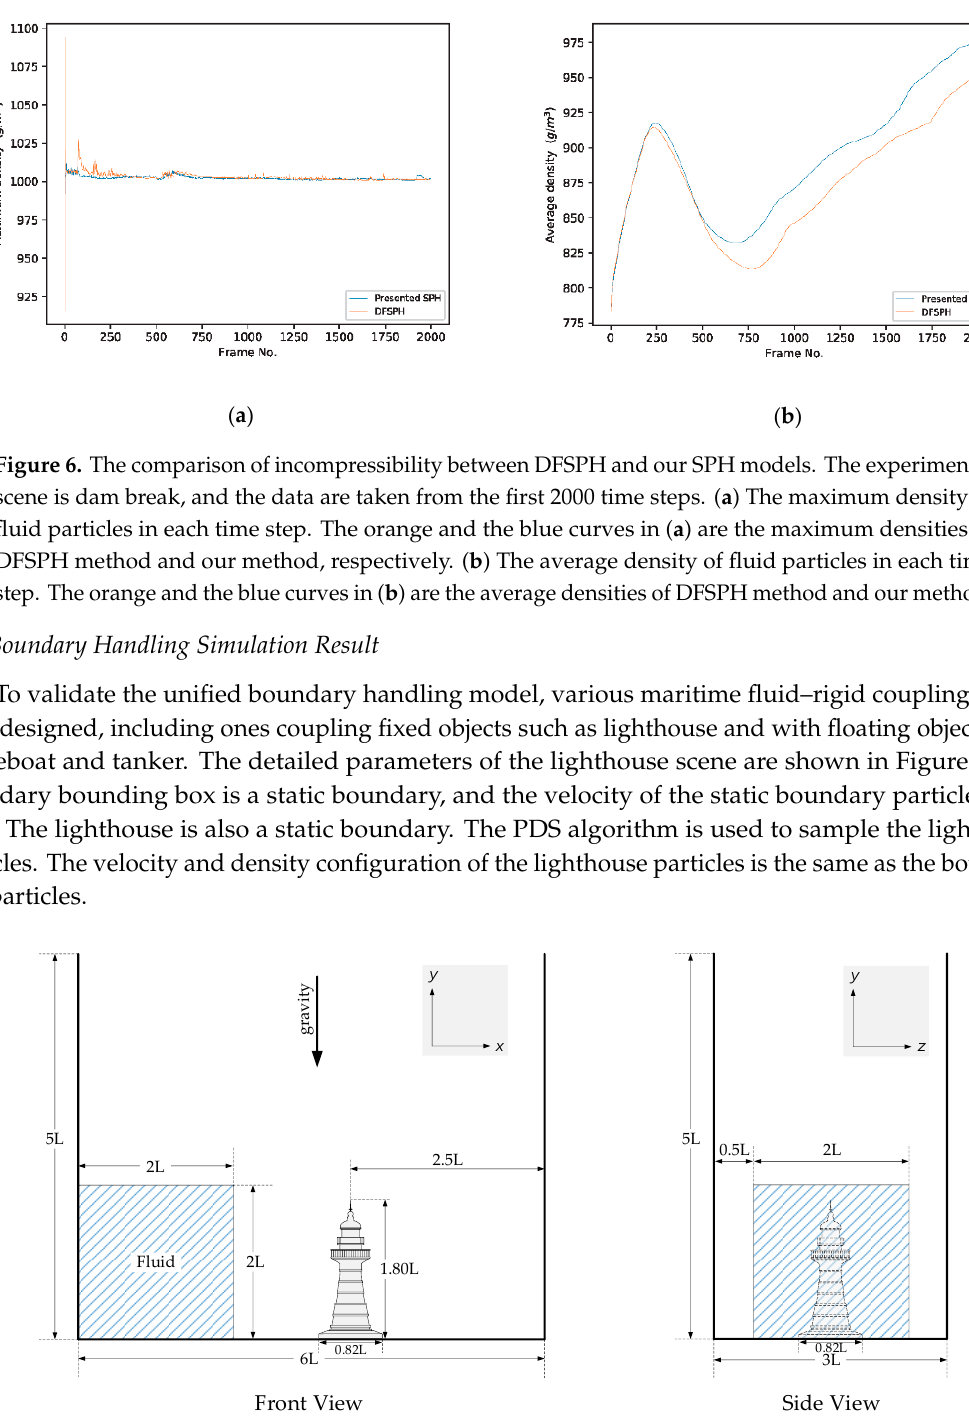
Figure 7. Design drawing of waves crashing against the lighthouse. The front and side view show the detailed parameters of the bounding box, lighthouse, and fluid block. In the side view, the lighthouse is located behind the fluid block, thus the lighthouse is represented by dashed lines.